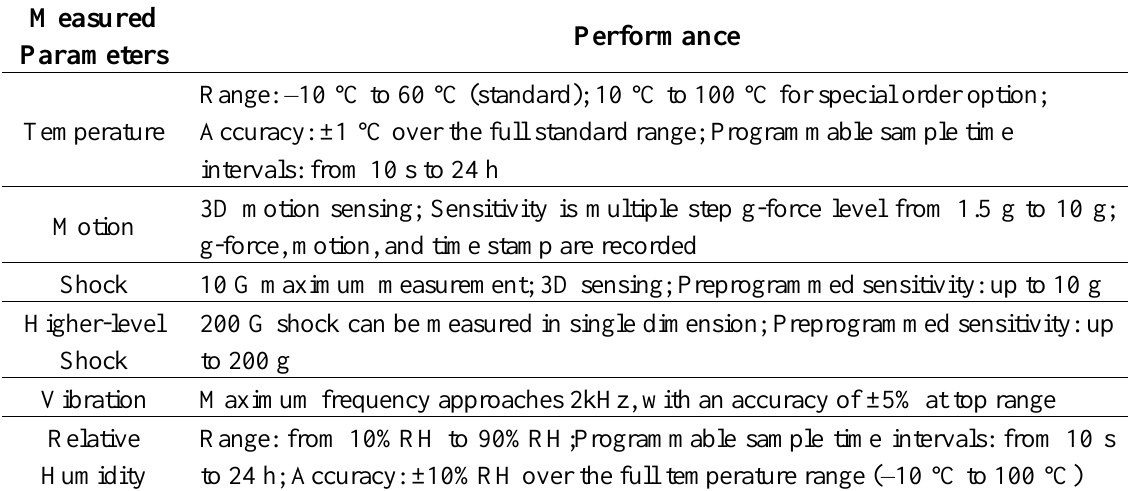
Table 3. Performance of the ePrognostic sensor tag